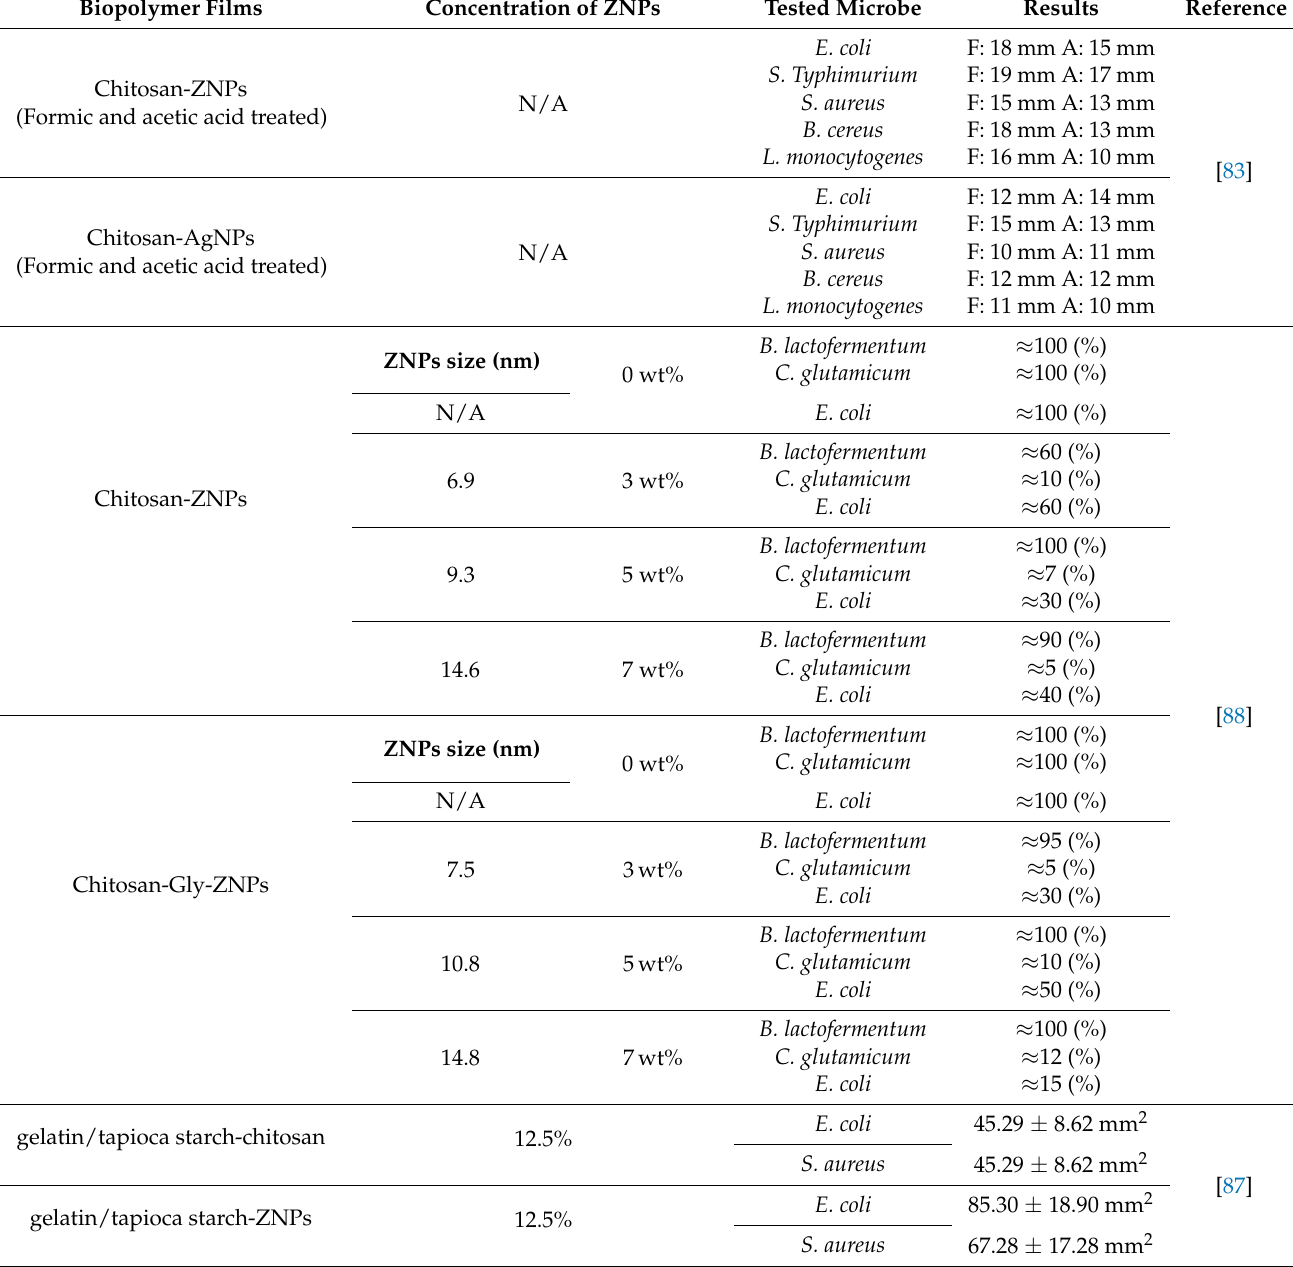
Table 2. Chitosan-ZNP films antimicrobial